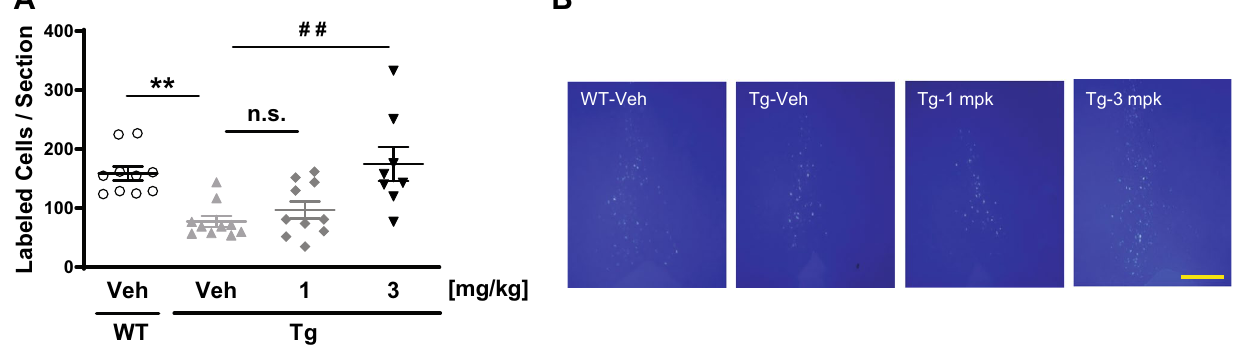
Figure 6. Rescue of impaired septohippocampal retrograde axonal transport in P301S tau Tg mice by T-518. Five-month-old WT and P301S tau Tg mice received 1 and 3 mg/kg T-518 or vehicle daily for 2 weeks, followed by injection of retrograde axonal tracer Fluoro-Gold into right hippocampus. Three days later, labeled neurons in the medial septum were counted in vehicle-treated, vehicle-treated Tg, and T-518-treated Tg ( A ). Representative image of the septal nucleus in each group was shown in ( B ). Data are expressed as mean ± SEM and as scatter plots, and analyzed statistically as follows: Student’s t test (** p < 0.01, WT vs. Tg), or two-tailed Shirley-Williams test ( ## p < 0.01, Veh vs. 1 and 3 mg/kg in Tg mice). n = 8–10. Bar = 500 μm.